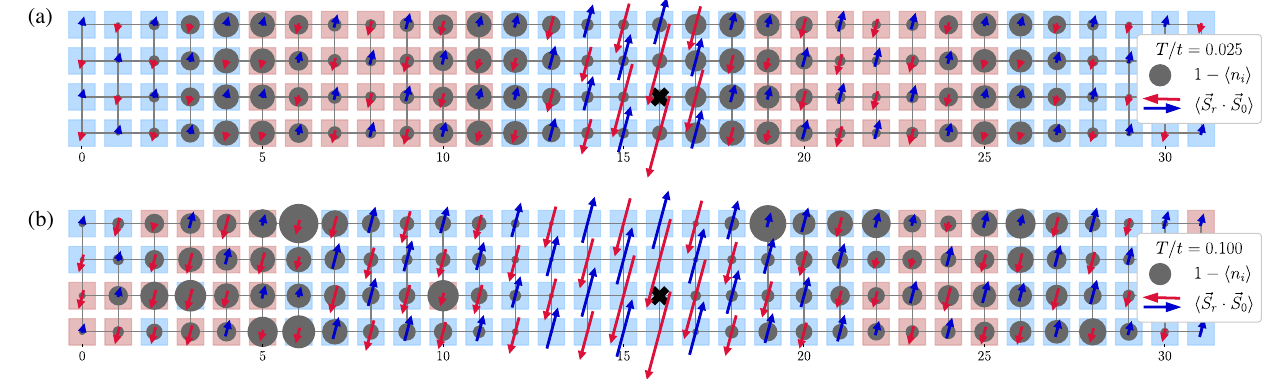
FIG. 1. Hole densities and spin correlations of a typical METTS state j ψ i i for U=t ¼ 10 at hole doping p ¼ 1 = 16 on a 32 × 4 cylinder. The diameter of black circles is proportional to the hole density 1 − h n l i ¼ 1 − h ψ i j n l j ψ i i , and the length of the red and blue arrows is proportional to the amplitude of the spin correlation h correlation. Red and blue squares indicate the sign of the staggered spin correlation ð − 1 Þ x þ y h antiferromagnetic domain walls of size approximately six to eight bounded by maxima in the hole density. This indicates a fluctuating stripe phase realized. (b) T=t ¼ 0 . 100 . We observe extended antiferromagnetic domains. No regular stripe patterns are